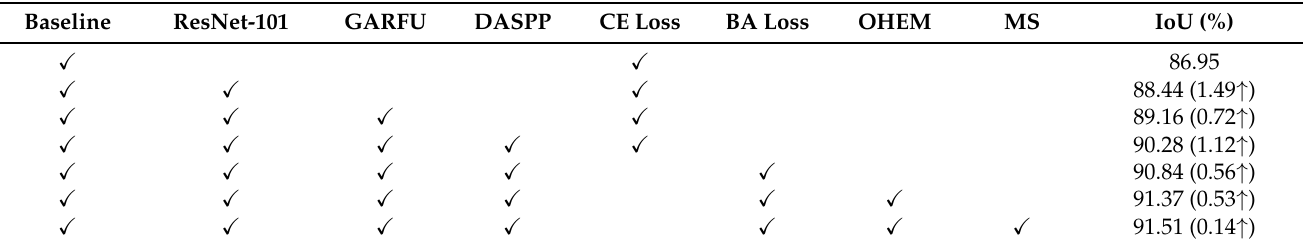
Table 2. Evaluation results for the network design, where U-Net serves as the baseline model. (cid:88) indicates the corresponding component is adopted. ↑ stands for the improvement of the IoU for using the adopted component, compared to the previous step.